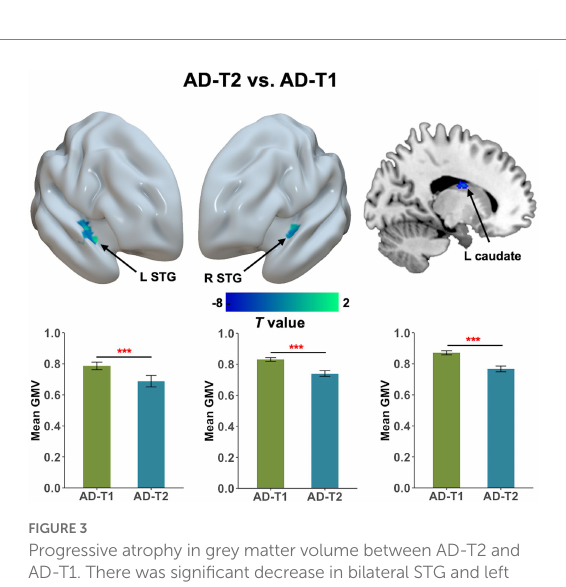
FIGURE 3 Progressive atrophy in grey matter volume between AD-T2 and AD-T1. There was significant decrease in bilateral STG and left caudate in AD patients over a one-year period. Error bars represent the standard error of the mean. Error bars represent the standard error of the mean. L, left; R, right. *** p < 0.001.